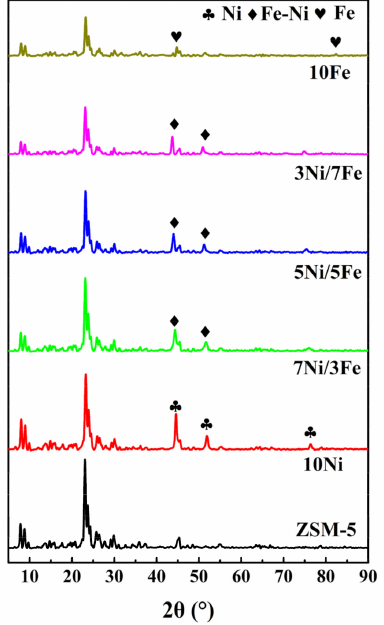
Figure 1. XRD patterns of ZSM-5 and modified